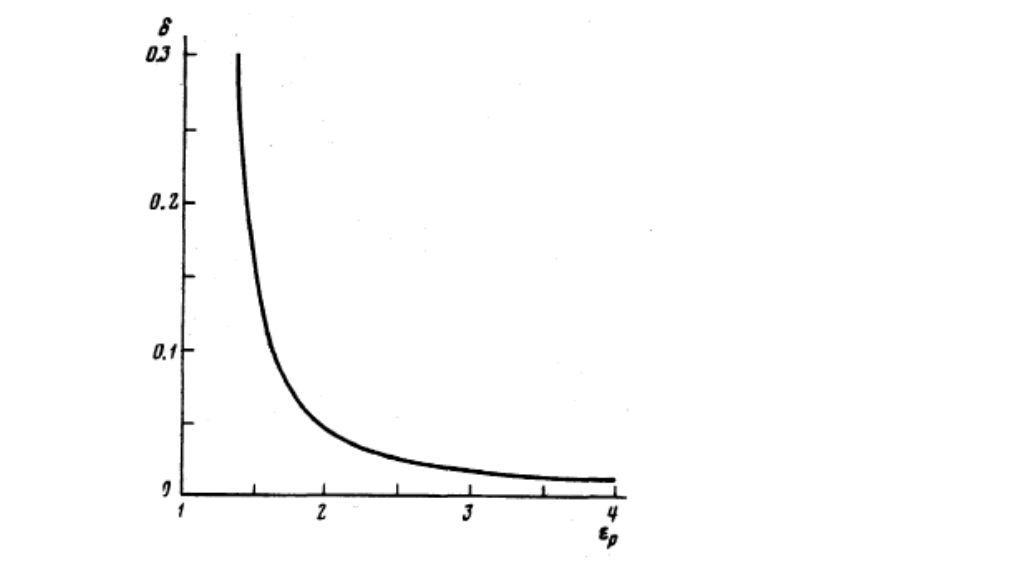
Figure 5. Correction on non-adiabaticity of the motion of nuclei, δ , cf. [7], for collisions U + U as a function of the positron energy (cid:101) p